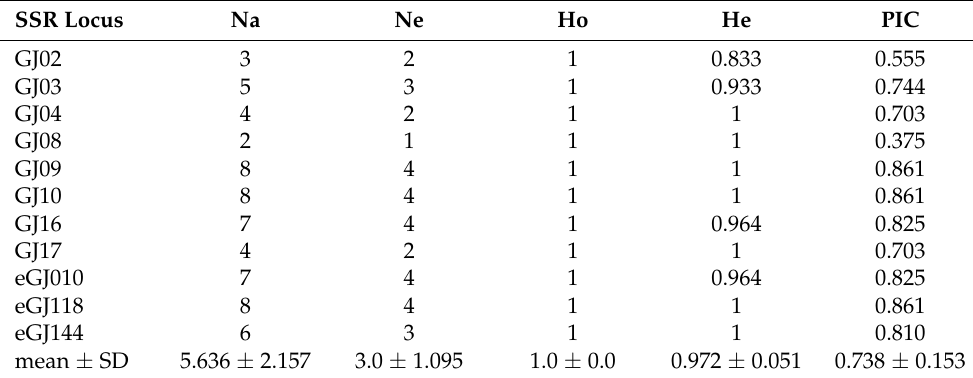
Table 3. Number of detected alleles (Na), effective number of alleles (Ne), observed heterozygosity (Ho), expected heterozygosity (He), and polymorphic information content (PIC) observed with 11 microsatellite loci used in this